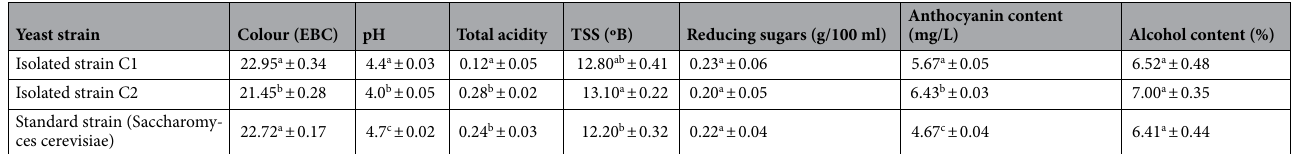
Table 1. Physicochemical characteristics of beer produced from black wheat by isolated yeast and control yeast ( Saccharomyces cerevisiae ). TSS total soluble solids. Values are mean of three replicates ± standard deviation (p < 0.05). Values with different superscript roman letters (a and b) in the same column are significantly different according to the Tukey’s range test (p < 0.05).